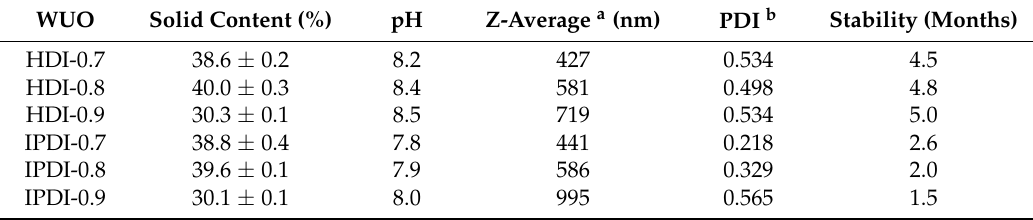
Table 2. Basic properties of WUOs synthesized using different isocyanates and NCO/OH mole ratios. WUO Solid Content (%) pH Z-Average a (nm) PDI b Stability (Months)